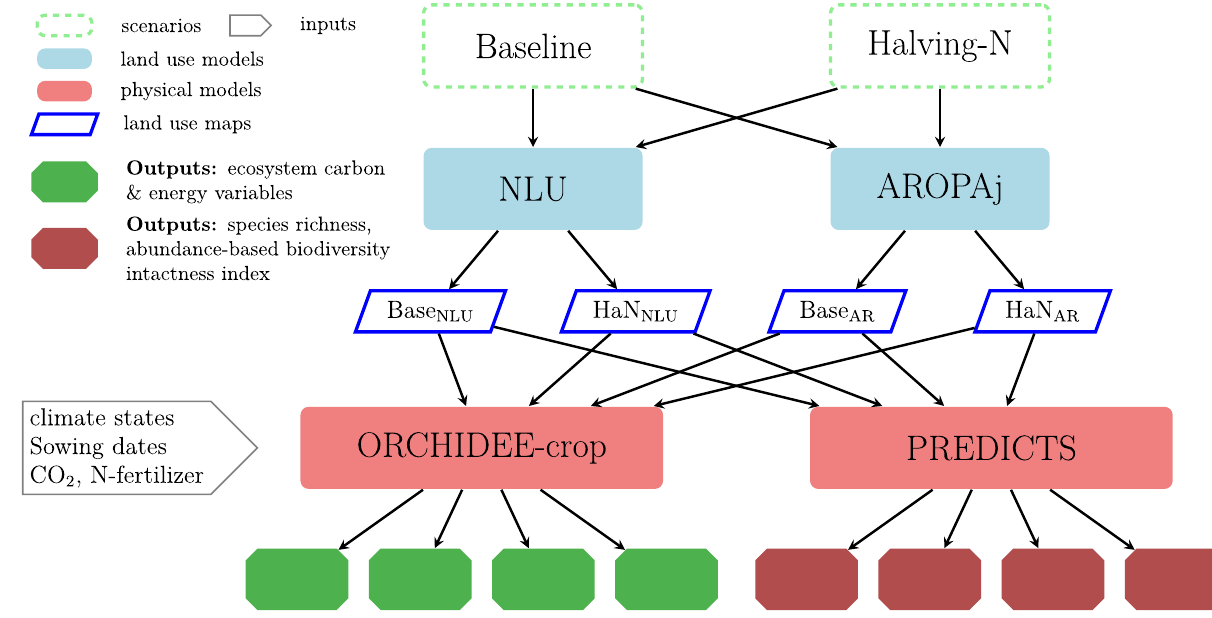
Figure 1. Schematic diagram illustrating the coupling of multi-scale land-use models. The multi-scale models coupled in this study are econometric, and economic models (NLU and AROPAj), an agricultural land surface model (ORCHIDEE-crop), and a biodiversity model (PREDICTS). Coupling means, we use the output of one model as an input to other models. In addition, we have performed one-way coupling and there is no two-way interaction between models. Each economic model generates two land-use maps corresponding to Baseline and Halving-N scenario which are inputs (2 from NLU and 2 from AROPAj) to ORCHIDEE-crop and PREDICTS. The ecosystem carbon (C) sequestration is simulated by ORCHIDEE-crop and biodiversity indicators are simulated by PREDICTS model. The abbreviations ‘Base NLU ’ and ‘HaN NLU ’ means Baseline and Halving-N land-use map generated by NLU model. The abbreviations ‘Base AR ’ and ‘HaN AR ’ means Baseline and Halving-N land-use map generated by AROPAj